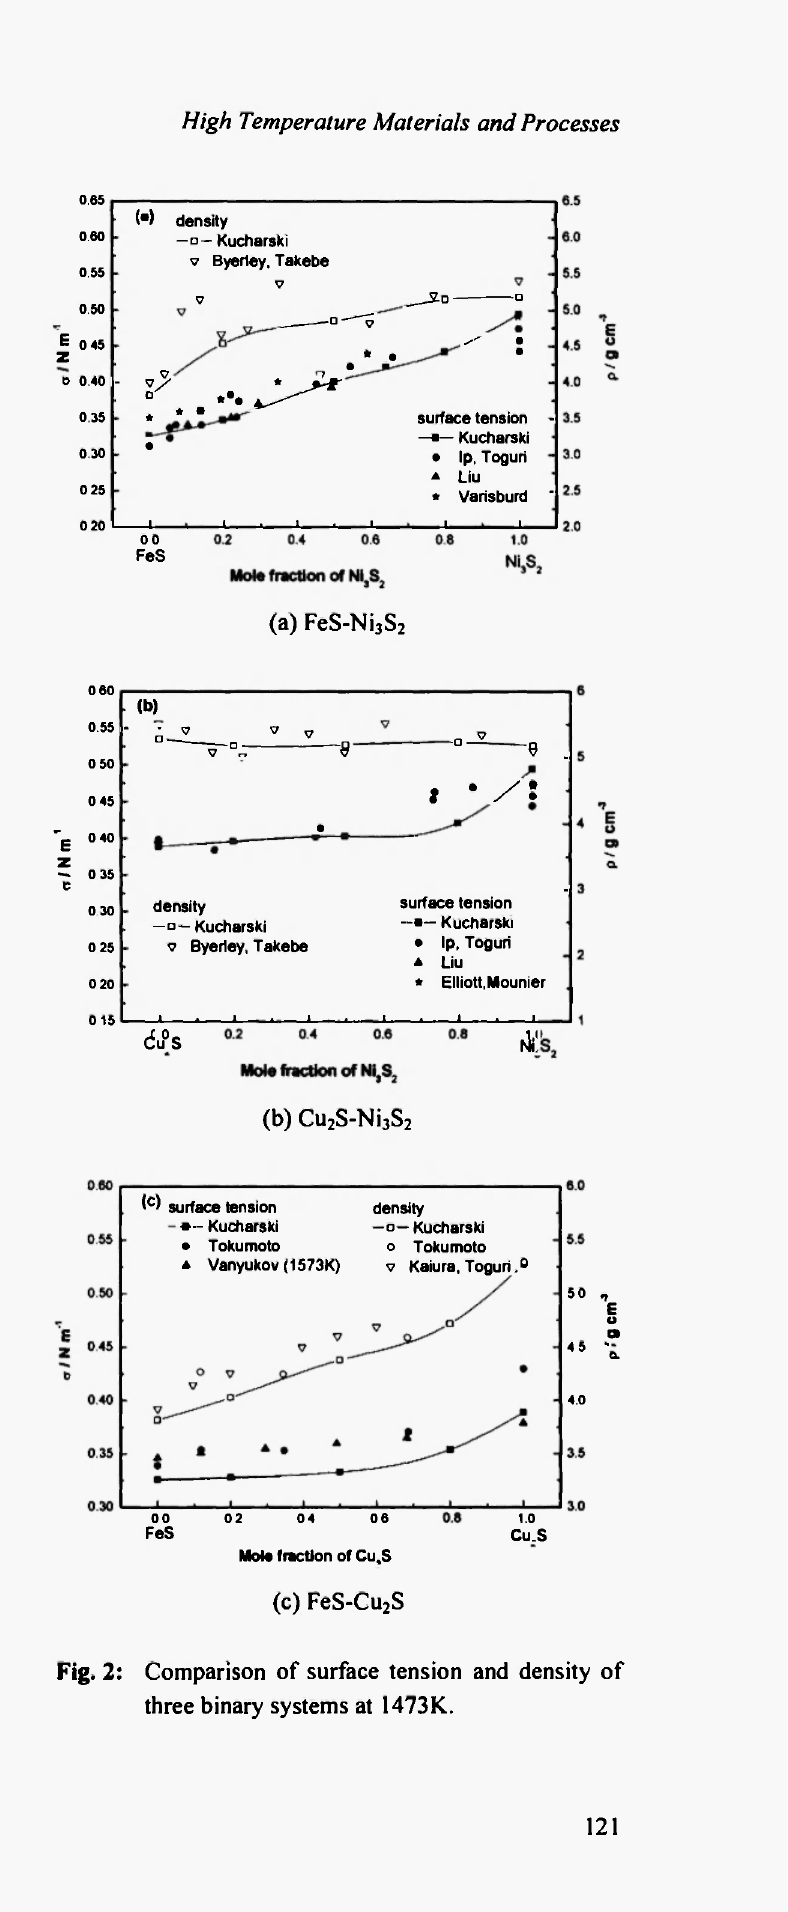
Fig. 2: Comparison of surface tension and density of three binary systems at